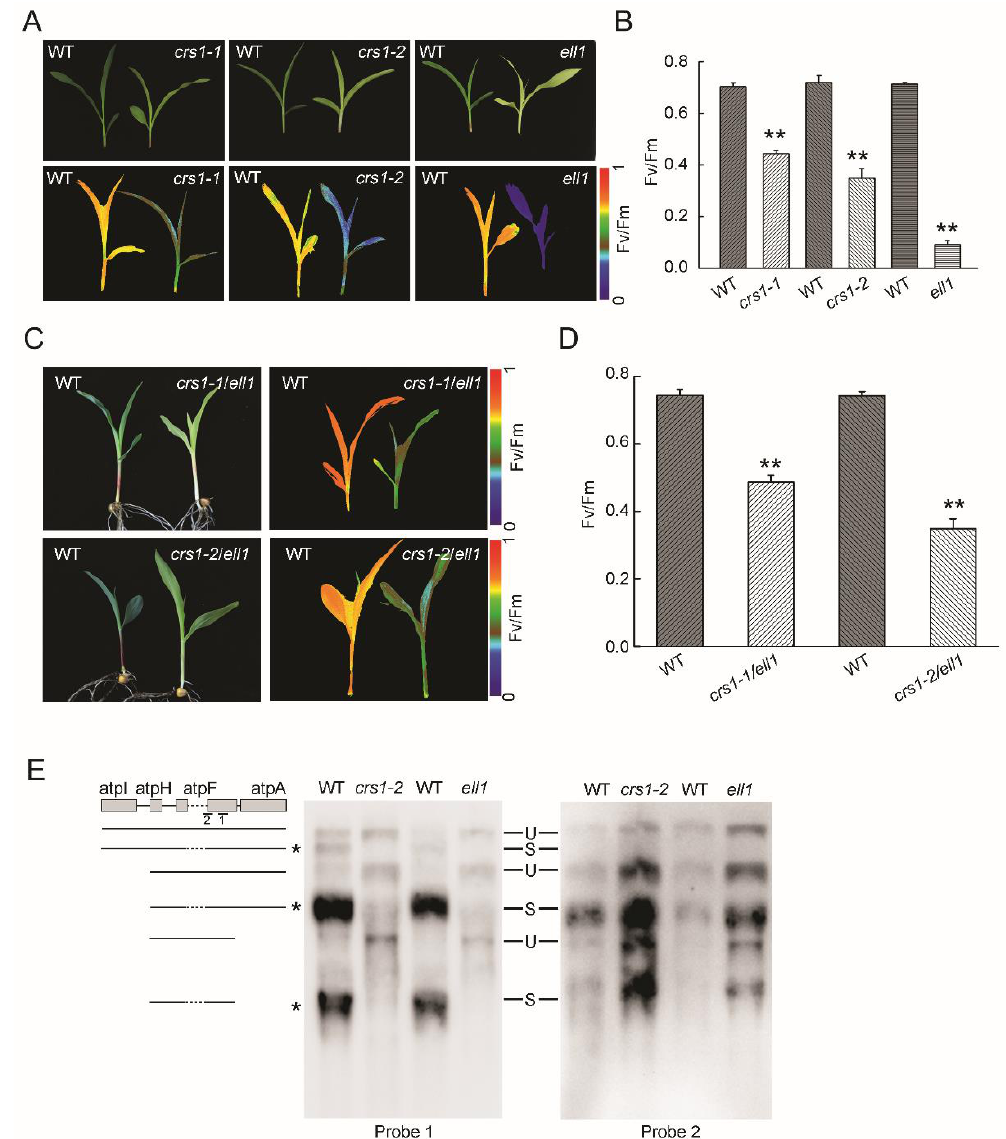
Figure 5. ZmELL1 encodes the CRS1 protein. ( A , B ) Growth and low-Fv/Fm phenotypes of the crs1 mutants. Images of three-leaf stage plants are shown in the upper panel. Plants were dark-adapted for 30 min at room temperature and Fo and Fm were measured using a CF Imager system. Fv/Fm was calculated as Fv/Fm= (Fm − Fo)/Fm shown in ( A , B ). ( C , D ) Growth and segregation of the F 1 hybrid generation. Images of three-leaf stage plants are shown in the left panel and low-Fv/Fm phenotypes are shown in the right panel. crs1-1/ell1 , individual with pale-green leaf of the hybrid F 1 population of heterozygous ell1/crs1-1 seedlings. crs1-2/ell1 , individual with pale-green leaf of the hybrid F 1 population of heterozygous ell1/ crs1-2 seedlings. Asterisks in ( B , D ) indicate where the WT and ell1 differ significantly (** p < 0.01, Student’s t -test). All of the data are presented as the means ± SD ( n ≥ 3). ( E ) RNA gel blotting illustrating the atpF splicing defect in crs1-2 and ell1 mutants. Total RNA from wild-type (WT), crs1-2 , or ell1 seedlings was analyzed by hybridization with an atpF -specific probe (1 and 2). RNA bands marked with asterisks lack the atpF